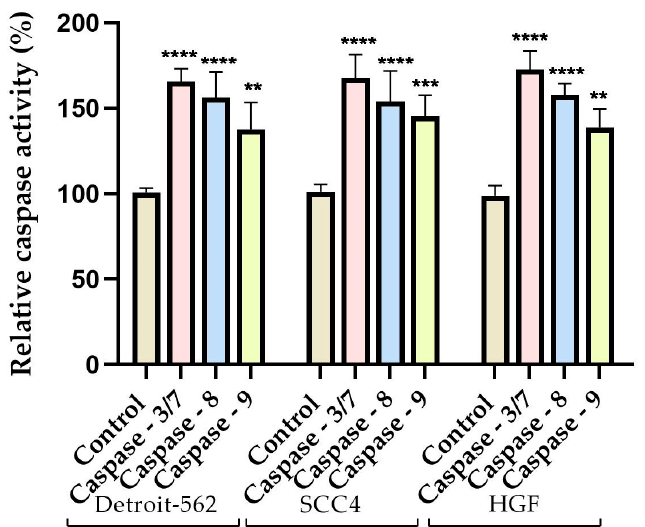
Figure 12. Induction of caspases-3/7, 8, and 9 in Detroit-562, SCC4, and HGF cells, after UVB (5 J/cm 2 ) exposure. Data are presented as mean ± SD of three independent experiments, in reference to the non-exposure group. One-way ANOVA and Dunnett’s post hoc test were used to identify the statistical differences (** p < 0.01; *** p < 0.001 and **** p < 0.0001).